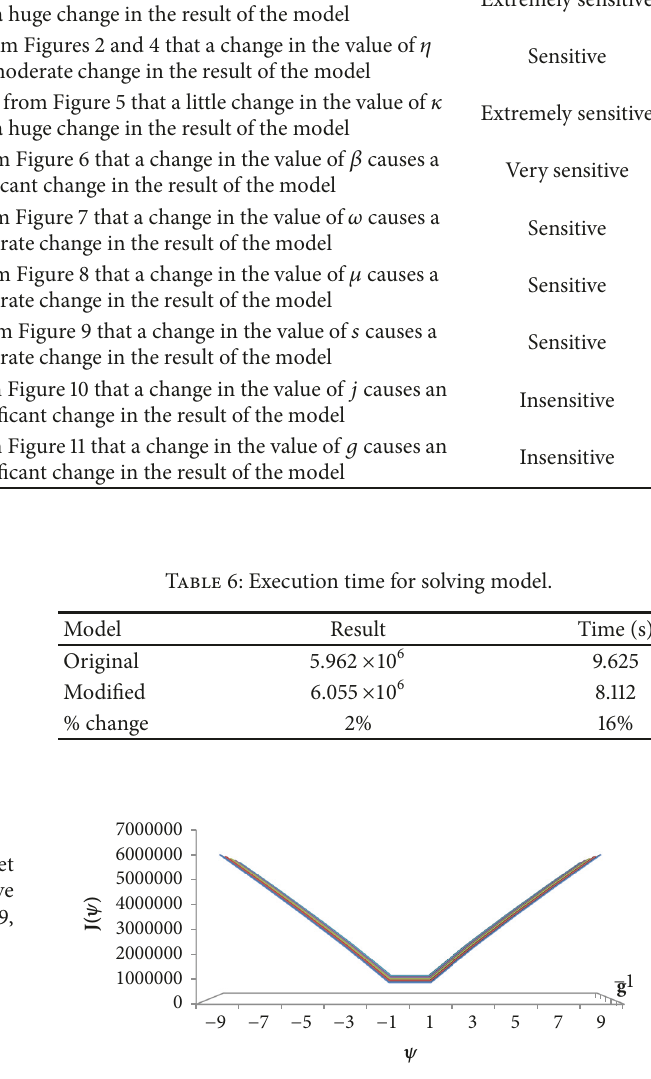
Figure 11: Graph of expected present value of the utility of asset 𝐽(𝜓) versus control 𝜓 and depreciation ratio 𝑔 while subjective discount rate 𝜂 and degree of relative risk 𝜆 are fixed at 0.1 and 0.9 ,